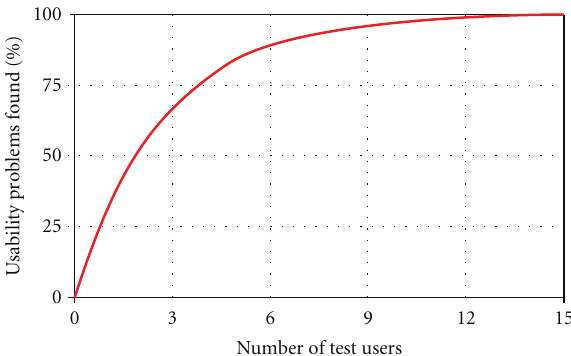
Figure 4: Rational for small samples in usability testing (adapted from